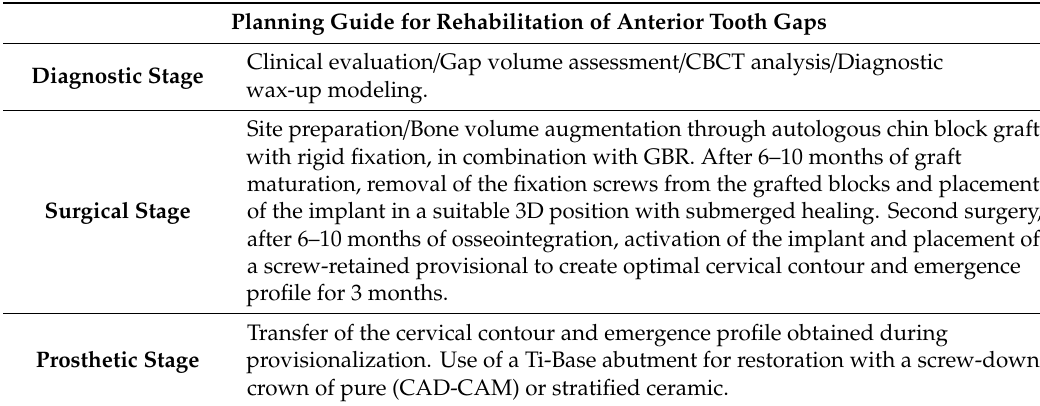
Table 1. Planning guide for rehabilitation of anterior tooth gaps.